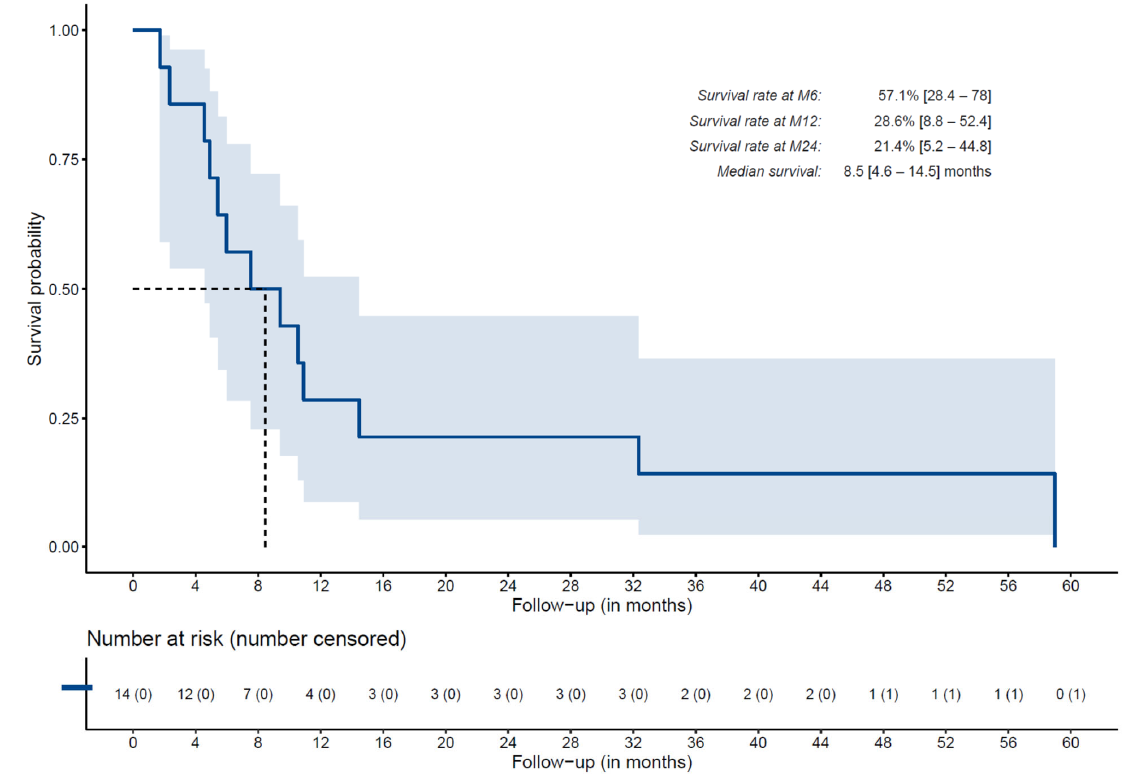
Figure 3. Overall survival after at least one injection of 188 Re-SSS lipiodol in the 14 heavily pre-treated HCC patients with progressive disease after sorafenib.